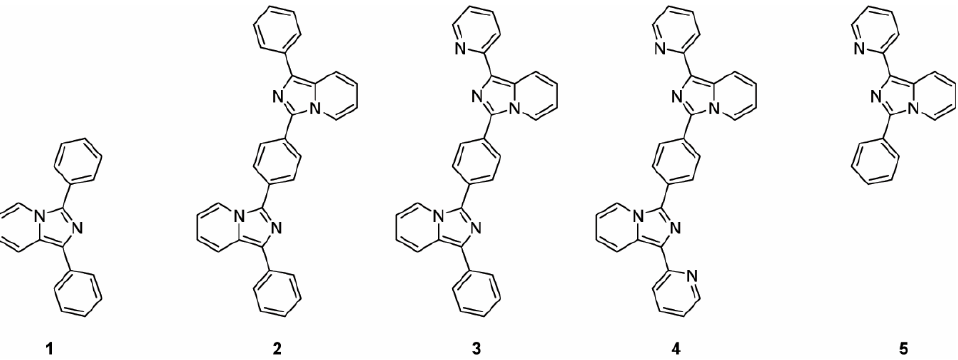
Figure 1. Structures of the synthesized compounds ( 1 – 5